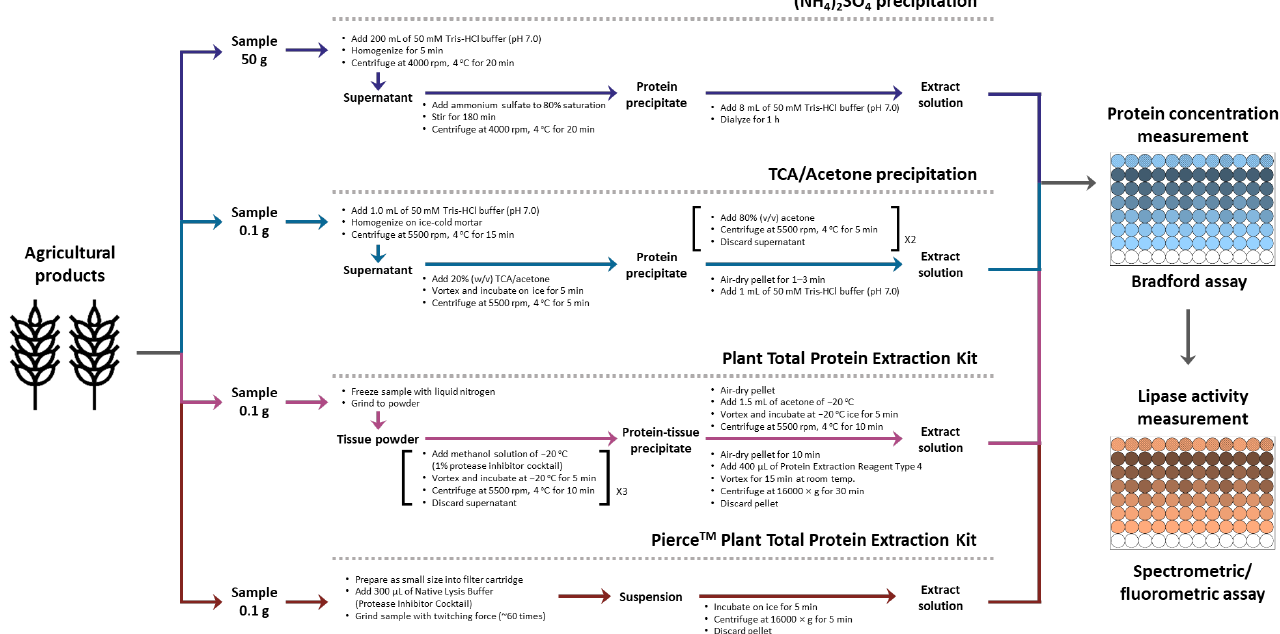
Figure 1. Schematic diagram representing workflow of protein extraction methodologies and the high-throughput screening of lipase